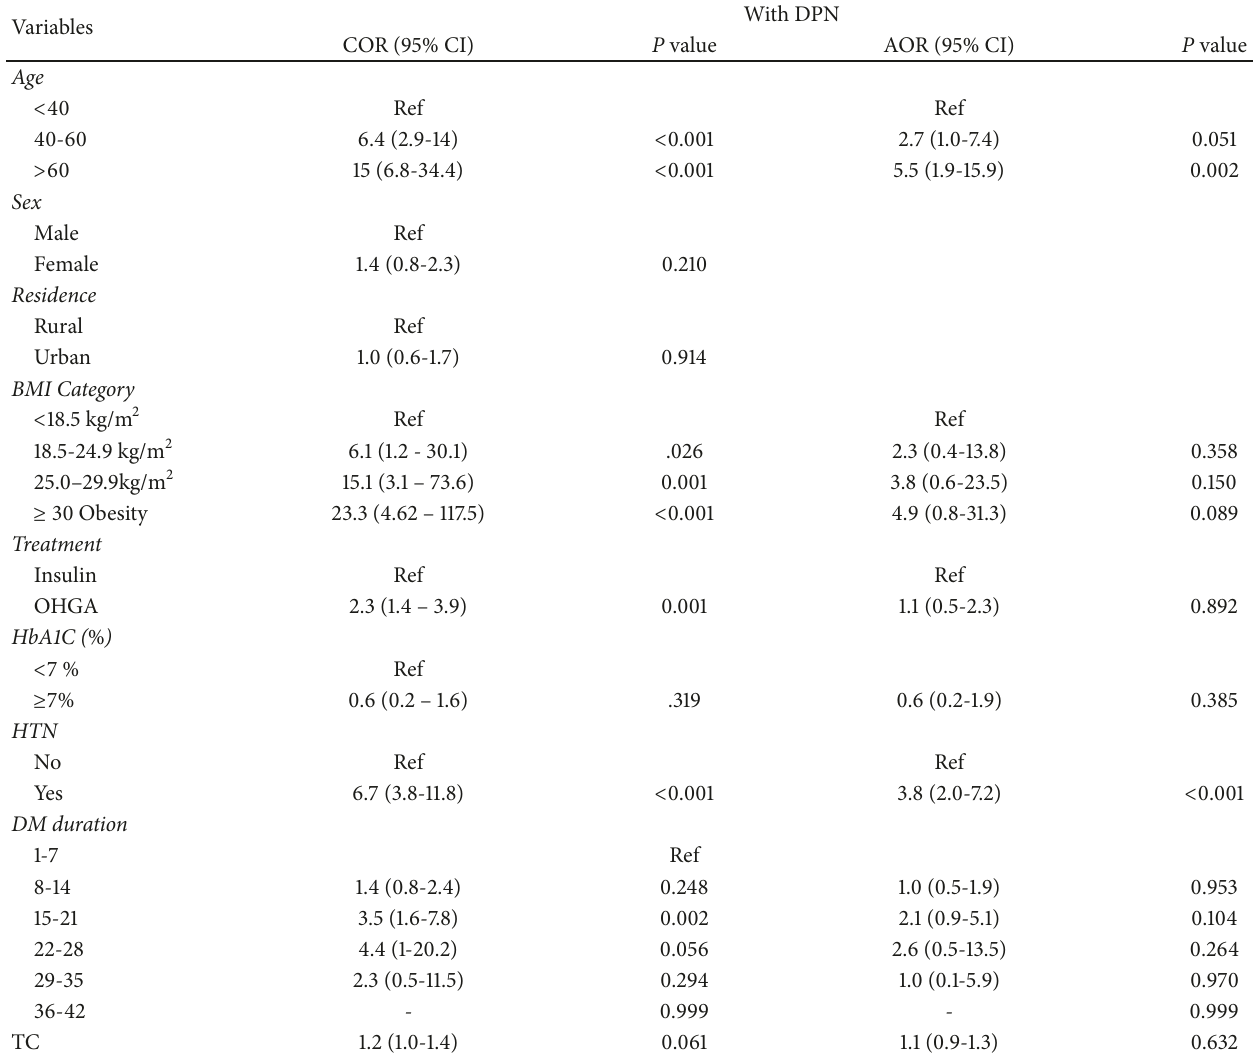
Table 4: Logistic regression of potential risk factors associations with DPN